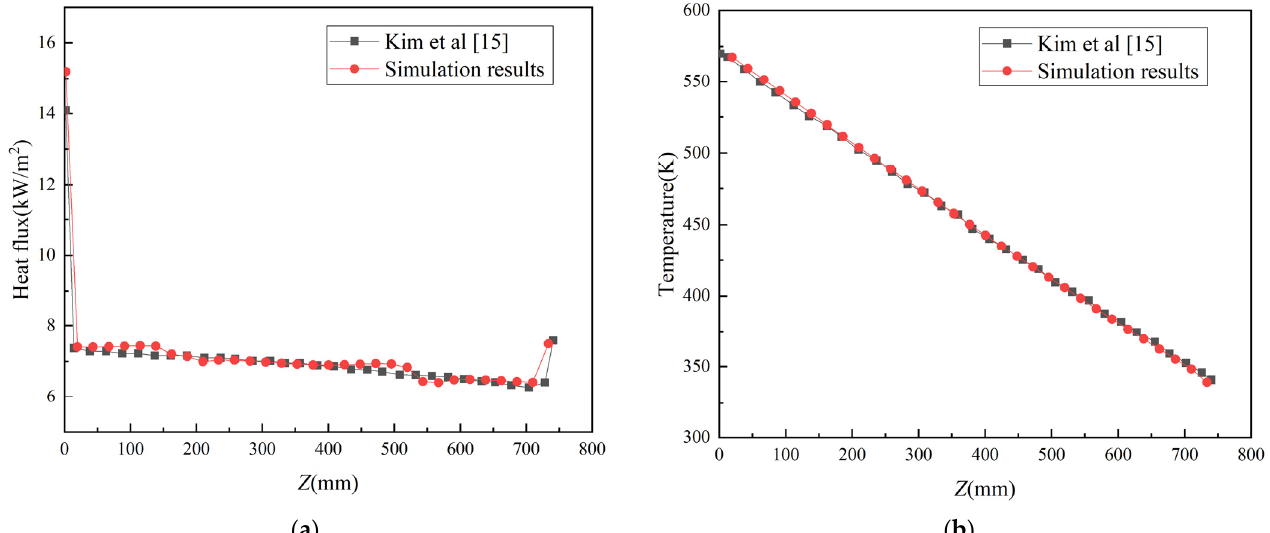
Figure 3. Comparison of heat flux and fluid temperature simulation results with those from Kim et al.: ( a ) heat flux; ( b ) fluid temperature.